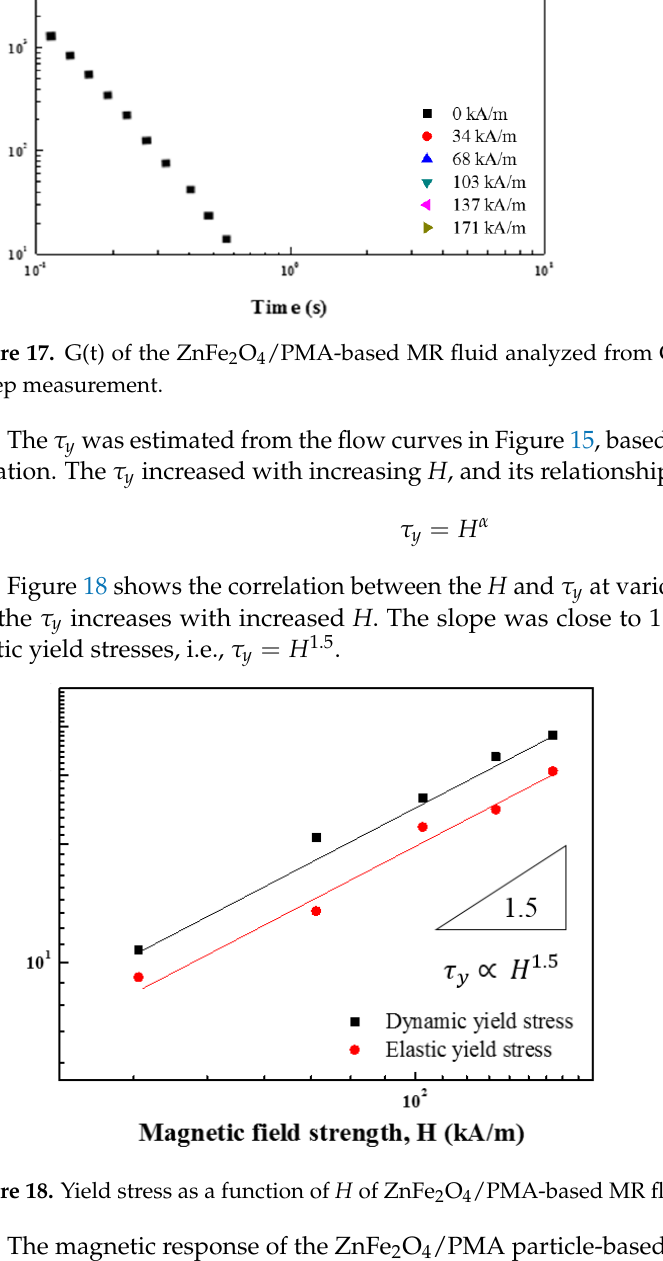
Figure 19. MR efficiency for ZnFe 2 O 4 /PMA-based MR fluid on 𝛾̇ under different H Finally, it can be further noted that the ER performance of the ZnFe 2 O 4 /PMA-based ER fluid in this work is comparable to that of previously reported PMA-based ER fluids (our yield stress with 5 vol% is 50 Pa, while 10 vol% from Ref. [50] is 103 Pa and 5 vol% from Ref. [51] is about 50 Pa) even though their direct comparison is not easy because particle concentrations and particle size and shape of these ER fluids are not exactly same. Nonetheless, the merit of this work is that by producing the core-shell structured